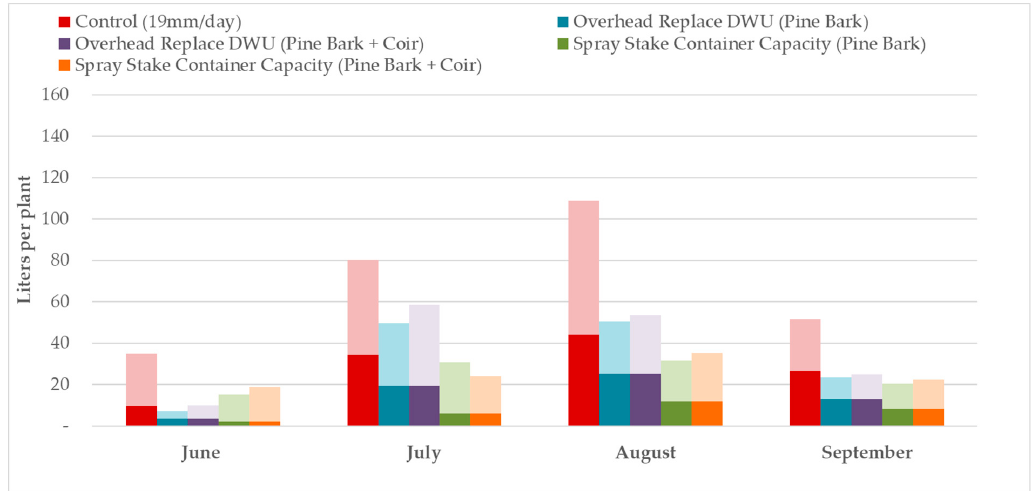
Figure 6. The relative contributions of water scarcity footprint of irrigation water applied (WSF iwa ) and water scarcity footprint from water dilution requirement (WSF wd ) on the monthly WSF of woody plants grown in 10.2 L containers for data collected in June through September 2018, under five irrigation regimens in a model research nursery in Michigan. For each color, darker shade is WSF iwa and lighter shade is WSF wd .